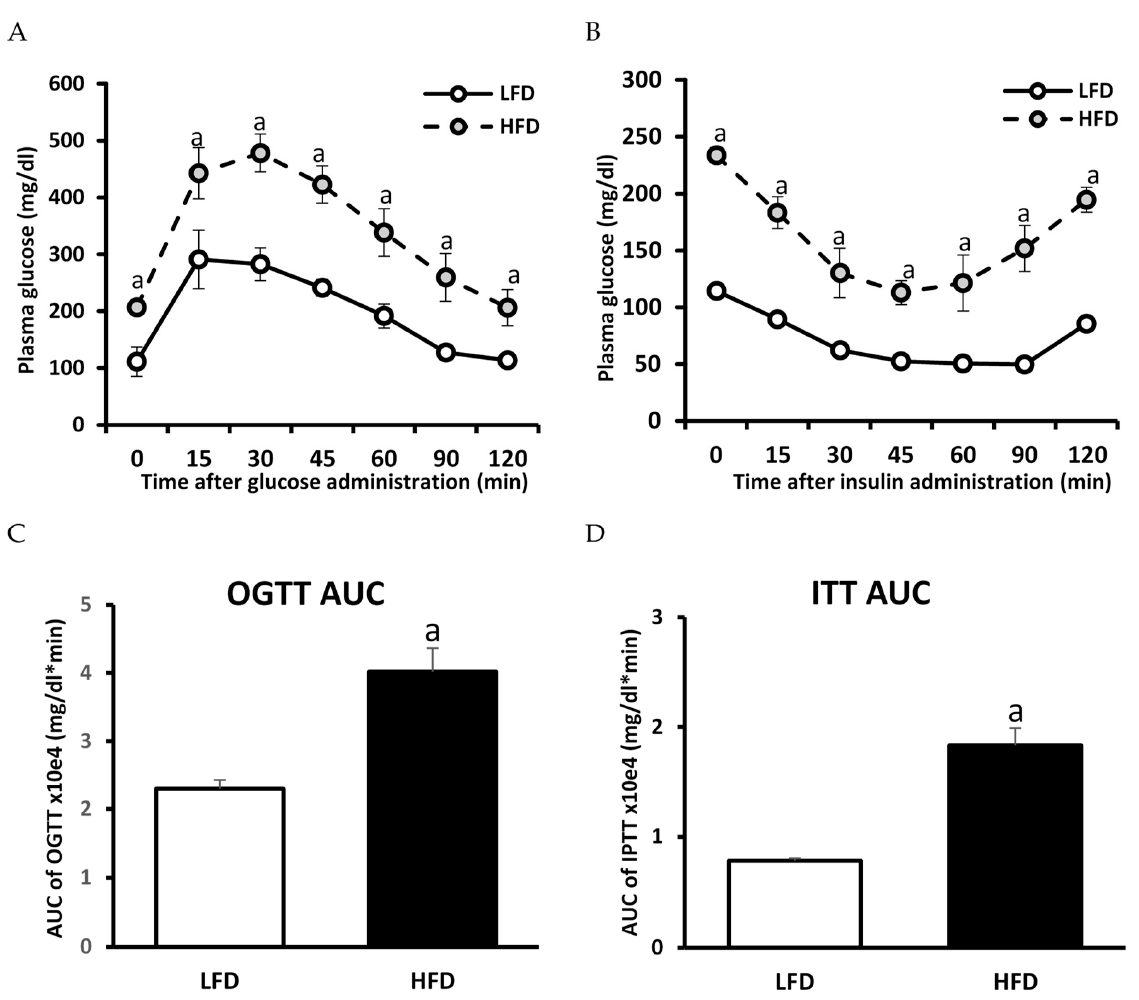
Figure 3. Impact of high-fat diet (HFD) consumption on plasma glucose profile during oral glucose tolerance test (OGTT) and intraperitoneal insulin tolerance test (ITT): Panel ( A )—plasma glucose profile during OGTT; Panel ( B )—plasma glucose profile during IPTT; Panel ( C )—area under the plasma glucose curve (AUC) for OGTT; Panel ( D )—area under the plasma glucose curve (AUC) for IPTT. Values are mean ± SD ( n = 6 per group); a— p < 0.05 vs. LFD; significance by t -test.